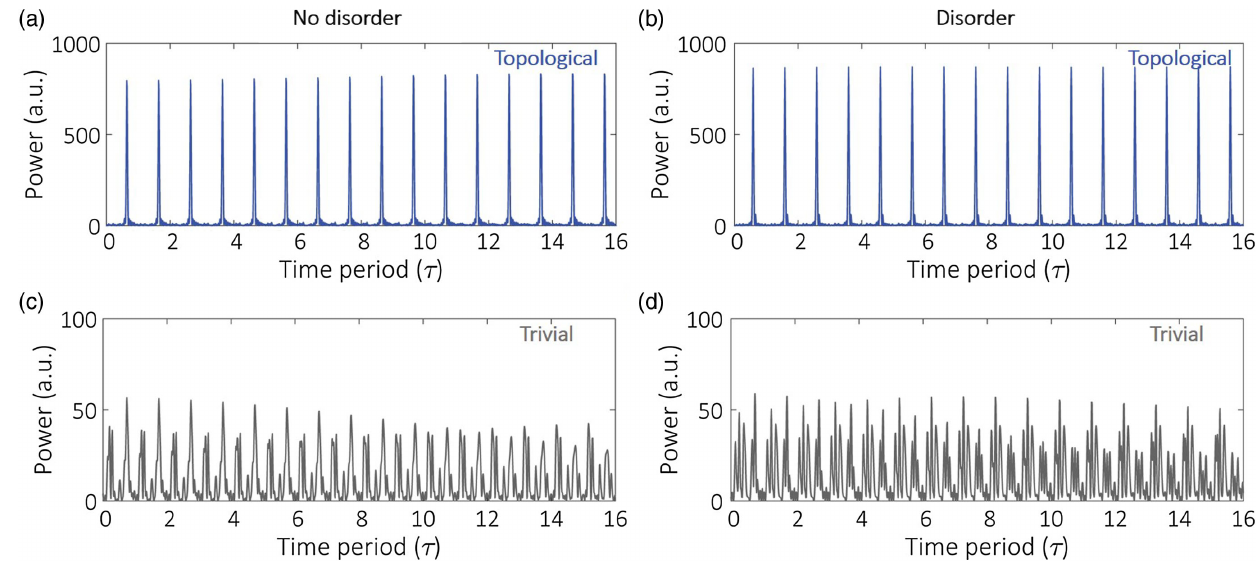
FIG. 4. Temporal dynamics of the laser output power (in arbitrary units, arb. units) emitted from the side resonators. The topological module emits mode-locked pulses (a) and maintains clean mode-locked operation even under considerable disorder with W ¼ 0 . 5 (b). On the other hand, the trivial laser system ( ϕ ¼ 0 ) displays multiple bursts of power, which broaden and fluctuate in the absence (c) and presence (d) of on-site disorder which introduces frequency mismatch among the resonators. The blue and gray curves indicate the results of topological and trivial lasers, respectively. The time axis is in units of τ ¼ 2 π = Ω . Note that in the simulations, background noise is present at all times. The background noise is distributed in ½ − δ ; δ (cid:2) and δ ¼ 0 . 2